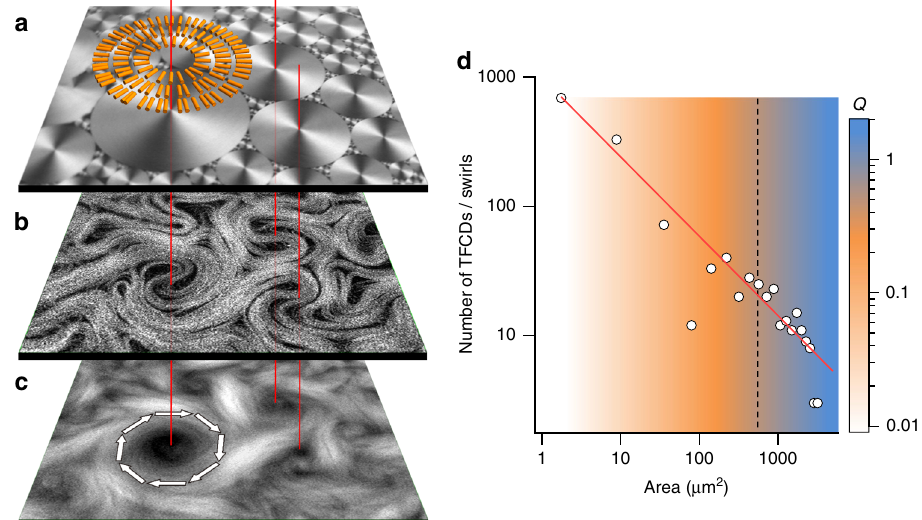
Fig. 2 Self-assembly of the active nematic in contact with the patterned interface. a Confocal re fl ection micrographs of the water/liquid crystal interface. The diagram illustrates the arrangement of the 8CB molecules at the interface. b Confocal fl uorescence micrograph of the AN. c Time averaged fl uorescence confocal micrograph (total integration time 300 s). Arrows indicate the direction of the circular fl ow. Line segments through the panels identify coincident regions, showing that swirls are in registry with underlying TFCDs. The fi eld of view is 240 × 240 μ m 2 (Supplementary Movie 2). d Size distribution of TFCDs in a 1 mm 2 window. The red solid line is a power law fi t to the data. The background colour map corresponds to experimental values of the winding number Q as a function of domain area. The dashed vertical line marks the characteristic area in the size distribution of the unconstrained turbulent regime (Fig. polyethylene glycol (PEG), and cross-linked by clusters of kinesin motor proteins 12 . Under continuous supply of ATP, the tens-of-